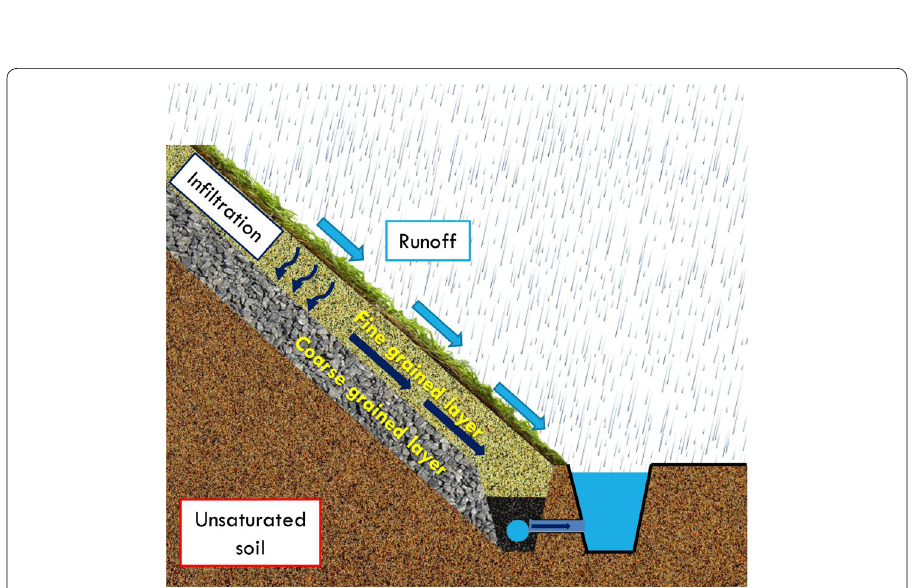
Fig. 10 Mechanism of capillary barrier